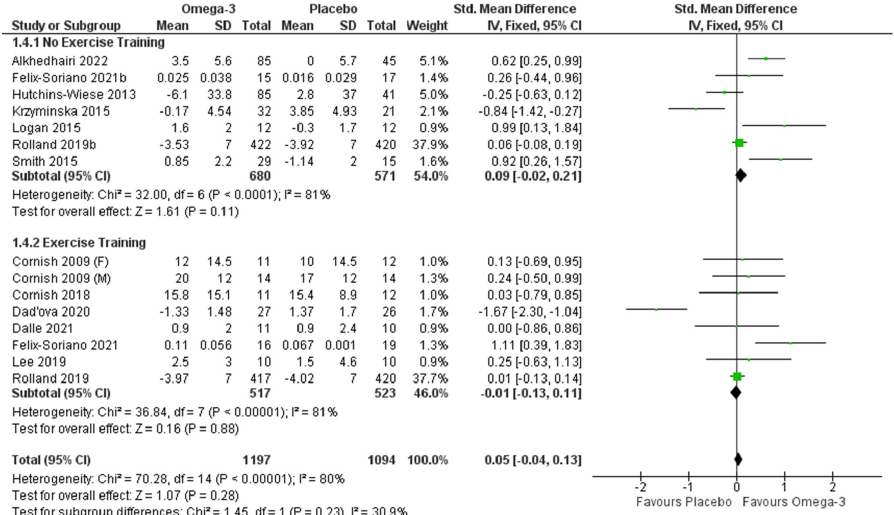
10 of 16 Figure 3. Pooled analysis of the impact of omega-3 supplementation on lower body strength with and without resistance training [27,31,33,35–37,40,42]. Two studies were identified to have publication bias from funnel plot analysis (i.e., they fell outside the funnel) [38,42]. When these were removed, the violation of heteroge- neity was no longer present. With these removed, the findings for ω -3 combined with RET were not significant, but the overall findings of ω -3 supplementation (with and without RET) were still significant ( p = 0.0007), and a significant subgroup difference was present, with ω -3 supplementation being superior when taken on its own when compared to taken in conjunction with RET ( p = 0.005). The pooled effects of ω -3 fatty acid supplementation on upper body strength with and without RET are displayed in Figure 4. When considered without RET, seven articles were analyzed [30,31,33,34,39–41], involving 2083 participants ( n = 666 males, 1417 fe- males). No significant effects of ω -3 were observed ( p = 0.11), although significant hetero- geneity was observed (I 2 = 81%; p < 0.001). When studies with a high risk of bias or publi- cation bias [29,31,34,39] were removed, there was a significant effect on upper body strength when ω -3 was supplemented without RET (SMD 0.11 [0, 0.23]) ( p = 0.05). Heter- ogeneity was reduced but still significant (I 2 = 77%; p = 0.002). Removing one of the remain- ing studies at a time still did not reduce the heterogeneity to a non-significant level. Seven